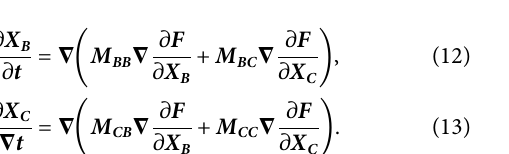
Frontiers in Materials |